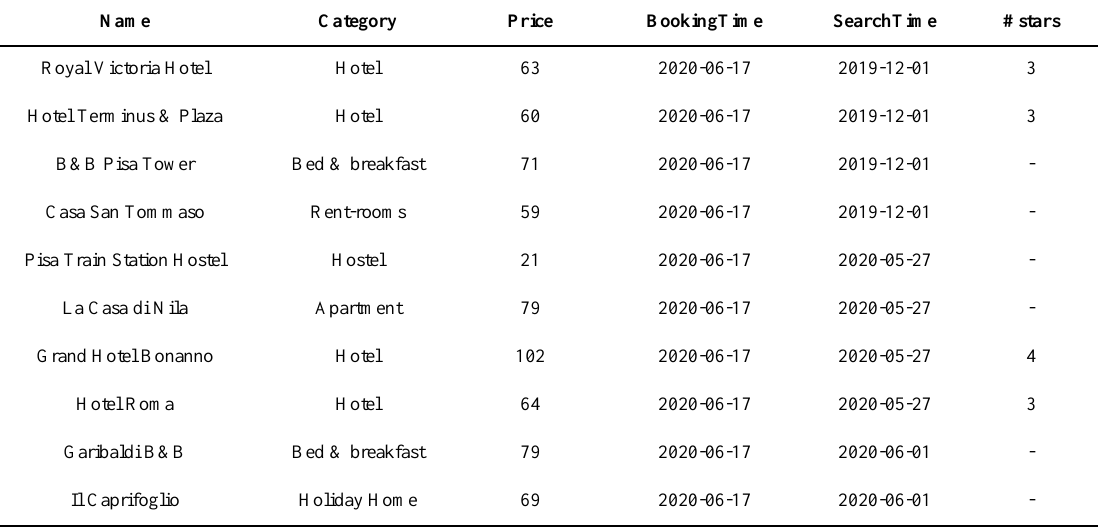
Table 4. Data extracted concerning the accommodation facilities for the Info & Review module